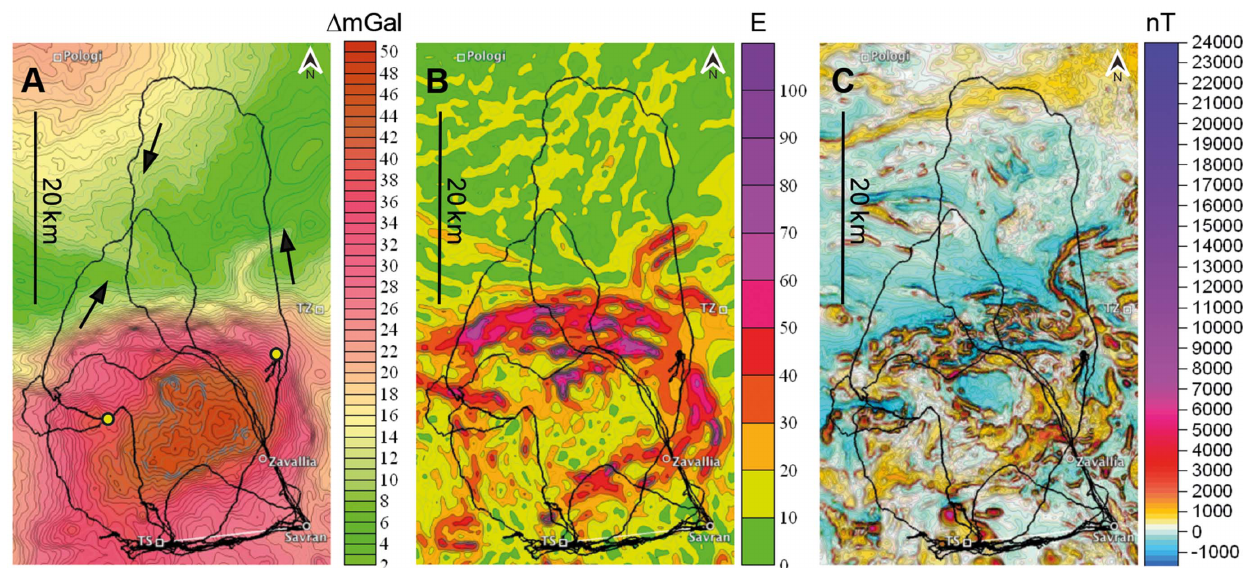
Figure 9. Last training release of S-pigeons west of the Savran loft. (A) Flight tracks on map of gravimetric anomaly, i.e. the change in gravity intensity. Yellow dots indicate birds resting more than 5 h. Three pigeons made long journeys to the north into the anomaly and back. Arrows show flight direction. (B) Tracks on a map showing irregularities of the horizontal gravity gradient (corresponding to the steepest gradients of gravimetric values). (C) Same tracks on a map with geomagnetic anomalies. The overall geomagnetic variation is relatively low (between -1000 and 1000 nT), with scattered peaks of higher intensity. For a topographical map: https://www.dropbox.com/sh/2yrhdtcyzt5uu99/ZFJeNJb0lk.